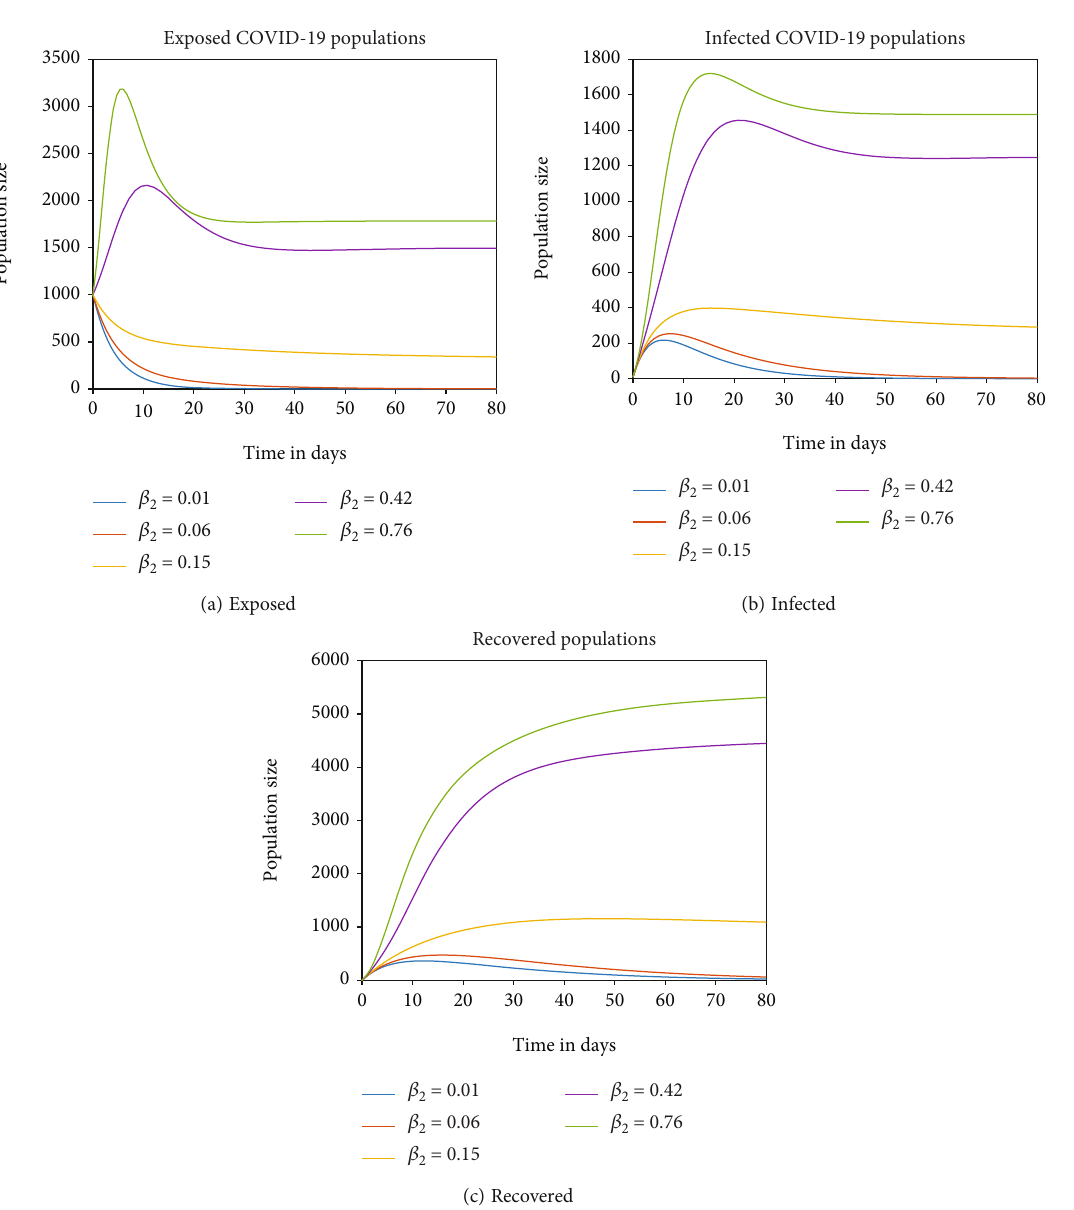
Figure 6: The e ff ect of the transmission rate ( β